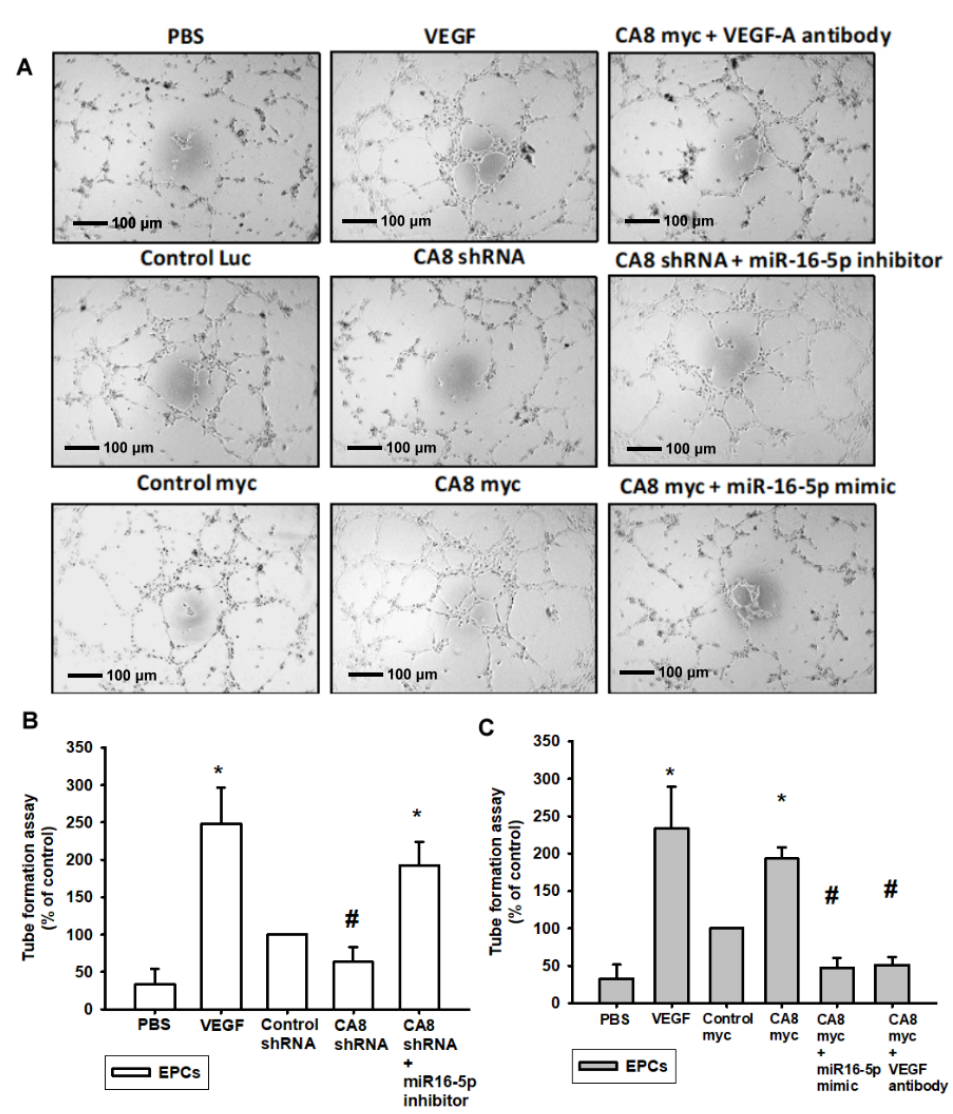
Figure 5. Effects of CAVIII on VEGF-A-induced capillary-like structure formation in human EPCs. EPCs were incubated with various grades of CAVIII expression CRC cells for 24 h. CRC. Cells were transfected with miR16-5p mimic or inhibitor then the conditioned medium (CM) was then collected and applied to endothelial progenitor cells (EPCs). ( A – C ) Cell capillary-like structure formation was examined by tube formation assays, respectively. Data represent the mean ± S.E.M. of four independent experiments. * p < 0.05 compared with the control group; # p < 0.05 compared with the CA8 myc group. Original magnification 200×. Scale bar; 100 μm.